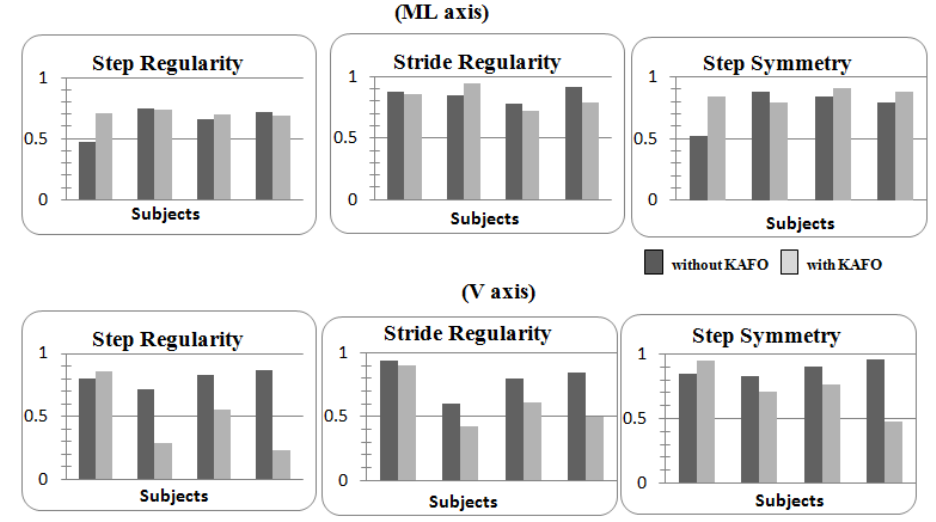
Figure 5. Comparison of step/stride regularity and symmetry evaluated both for the ML and V acceleration sensing axes. Values were normalized and expressed as non-dimensional indexes ranging from 0 to 1. Light grey and dark grey were used to discriminate between the trials carried out with and without the orthosis,